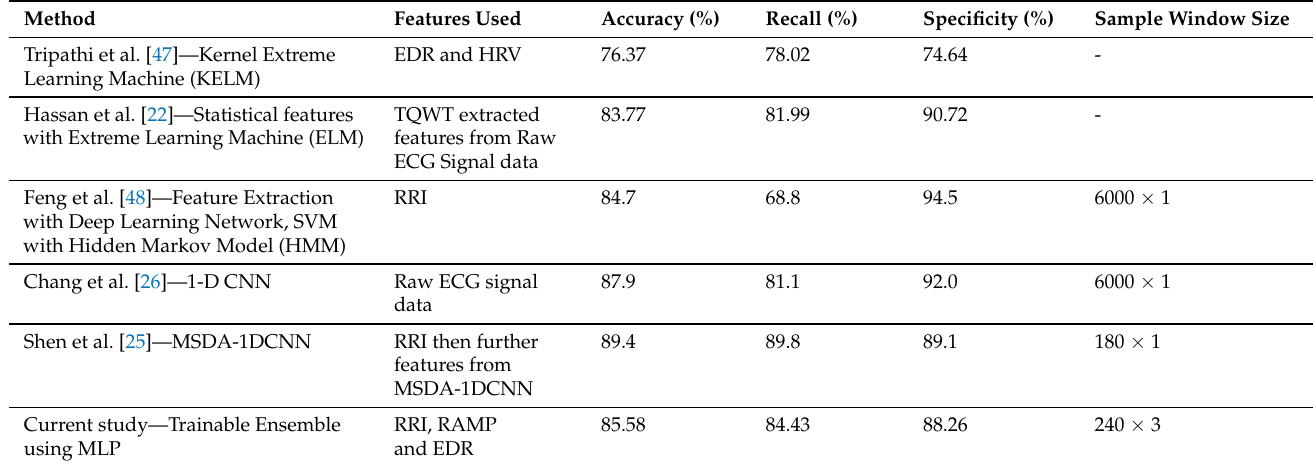
Table 6. Performance comparison of the previous works with our